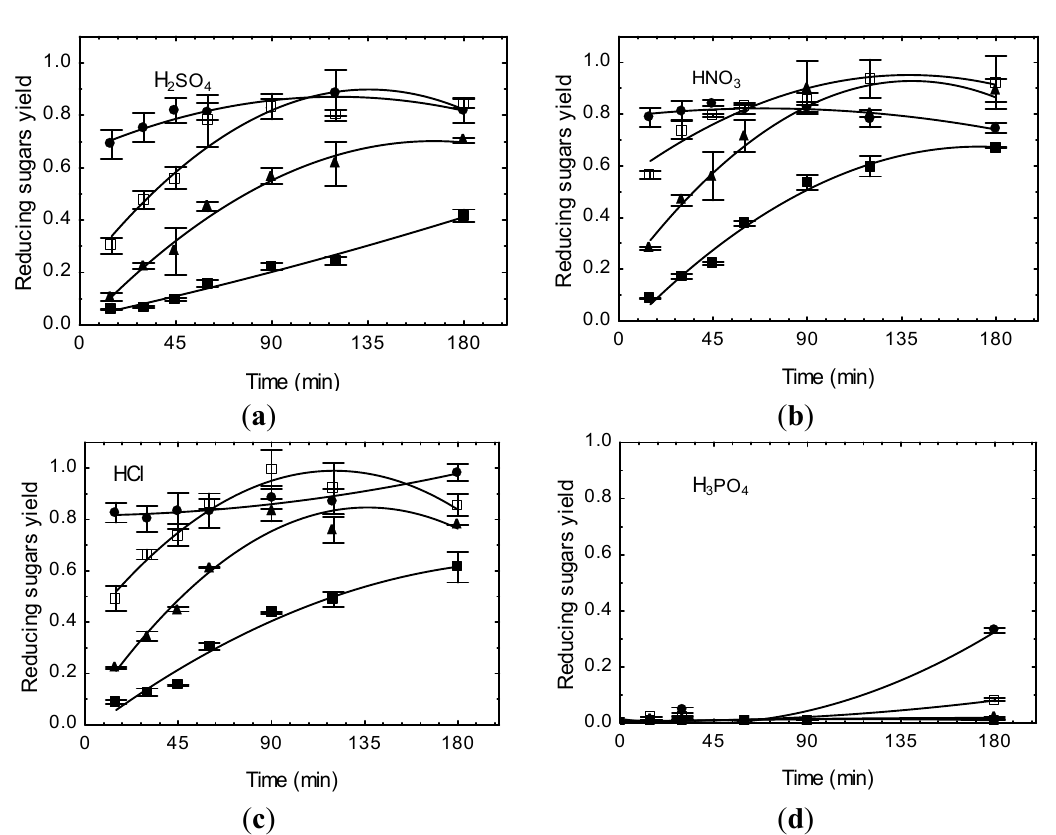
/g total sugars) kinetics from the hydrolysis eq SO ; ( b ) HNO ; ( c ) HCl; and ( d ) H 2 4 3